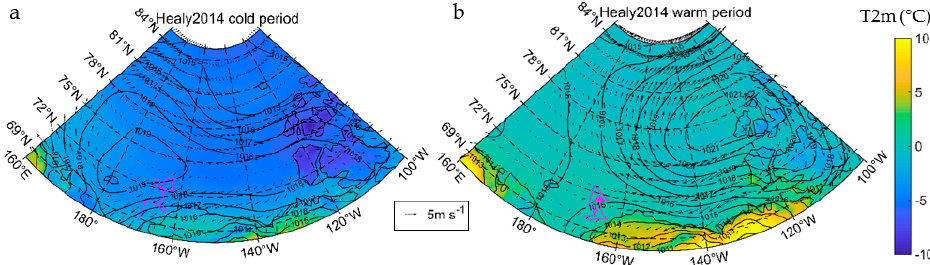
Figure 5. Period average of temperature ( ◦ C, shaded color), sea level pressure (hPa, contour), and winds (m s − 1 , arrow) in the Healy 2014 cold period ( a ) and warm period ( b ) The purple lines show the locations of the observations in each period.